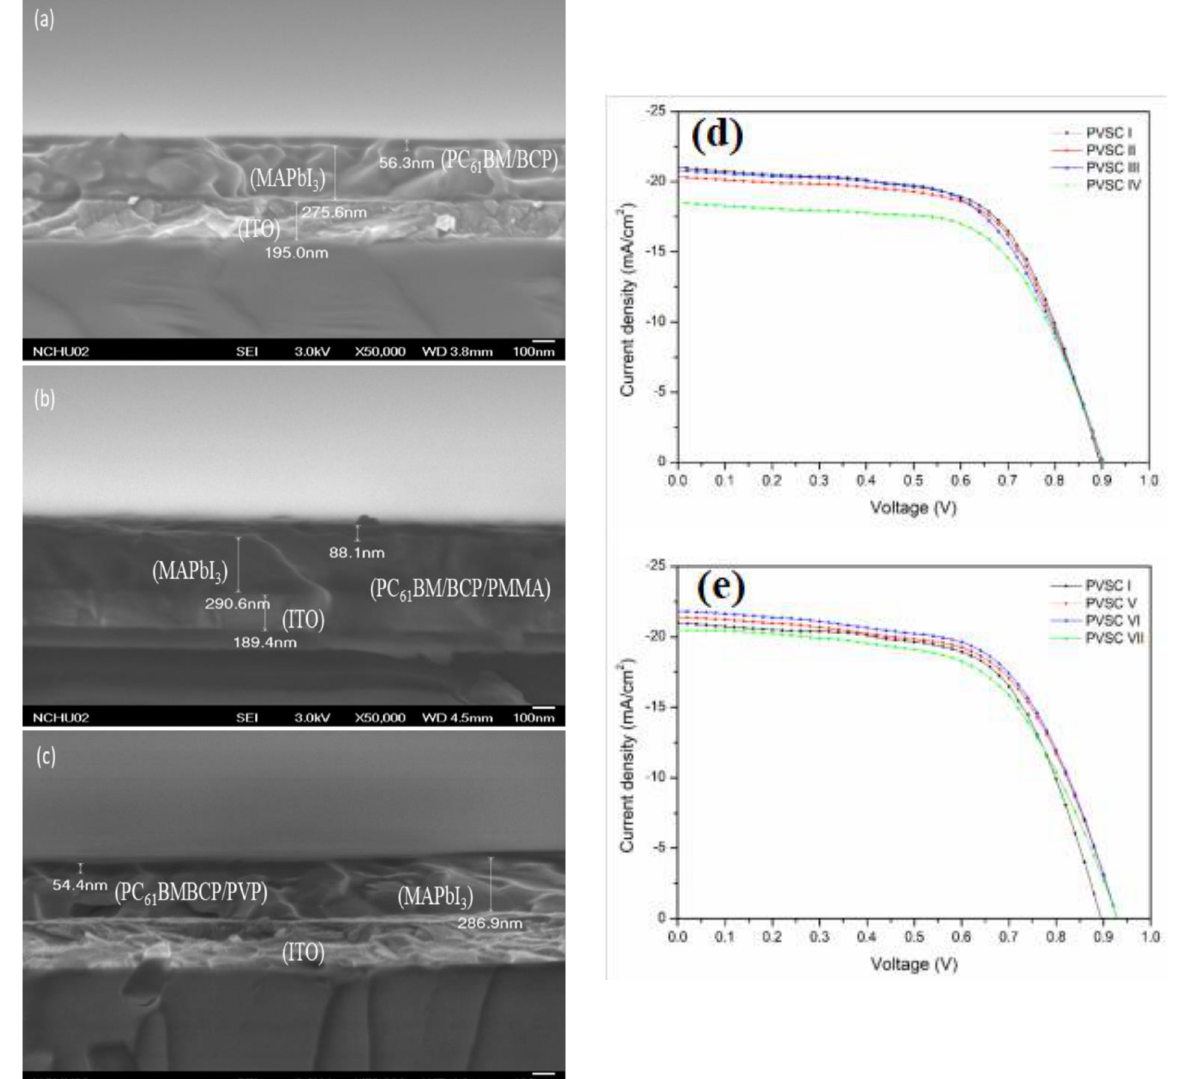
Figure 7. The cross-sectional SEM images of ITO/PEDOT:PSS/MAPbI 3 /PC 61 BM with BCP ( a ), BCP/PMMA ( b ), BCP/PVP ( c ) and the current density–potential plots of PSCs with BCP (PVSC I) ( d ) and ( e ), BCP/PMMA (PVSC II-IV) ( d ), BCP/PVP (PVSC V-VII)) ( e ) [176].